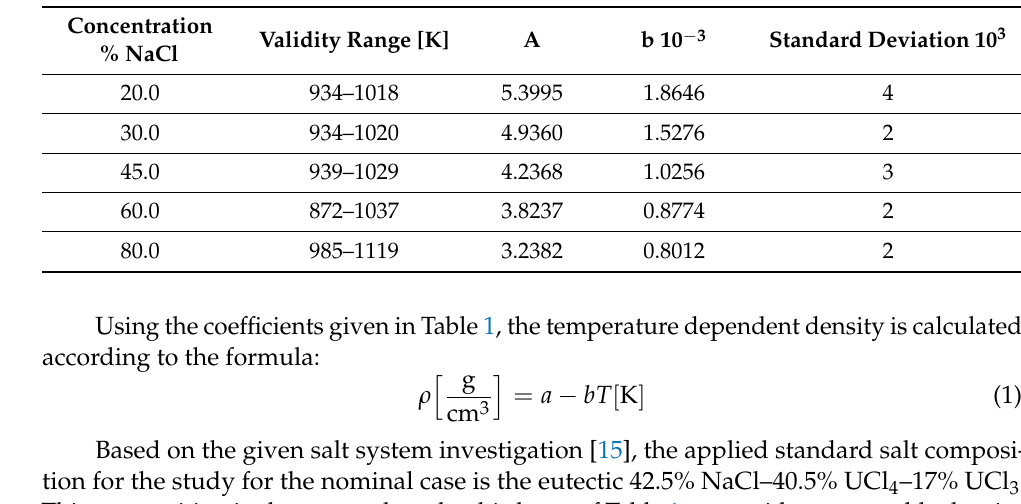
Table 1. Concentration dependent densities for the system NaCl-UCl 3 -UCl 4 with the uranium salt composition 30% UCl 3 + 70% UCl 4 and varying NaCl concentrations part reprinted from [1]. The experimental uncertainty in the density measurements is given with max ±